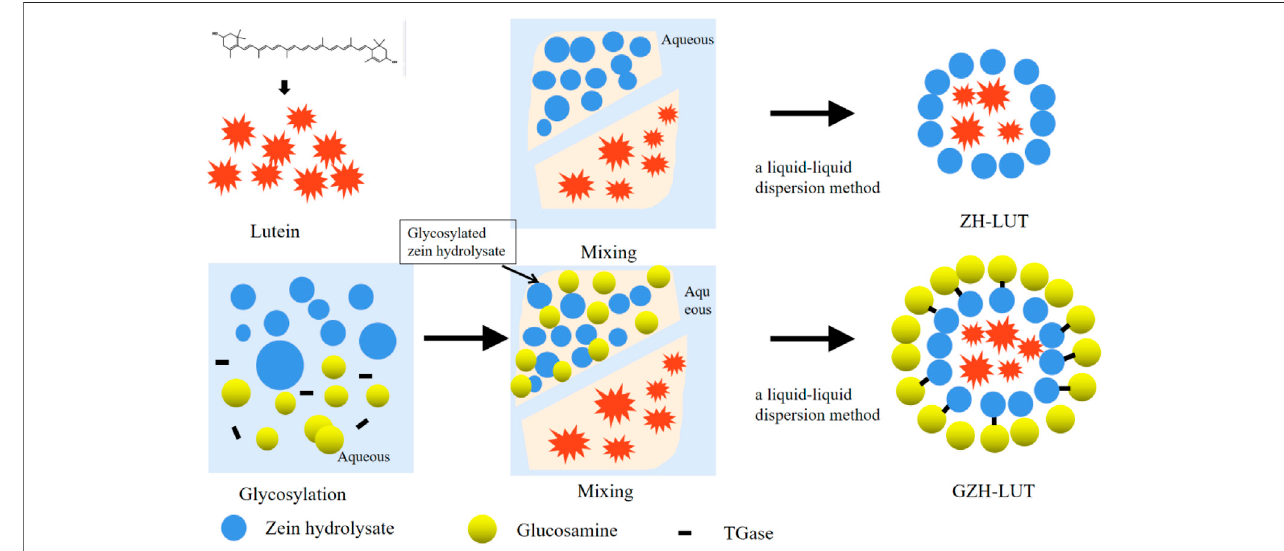
FIGURE 1 | Schematic diagram for the preparation of ZH-LUT and GZH-LUT.